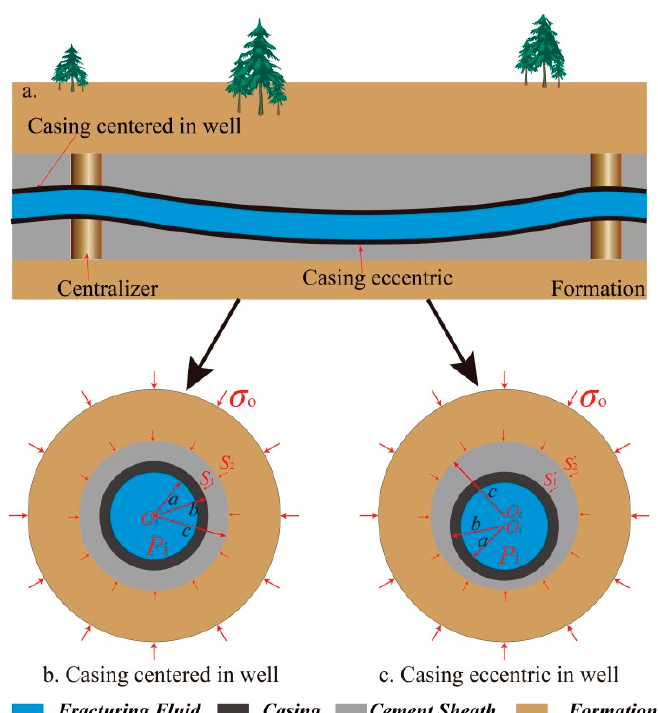
Figure 3. Sketch of a casing–cement–formation system in a horizontal well.